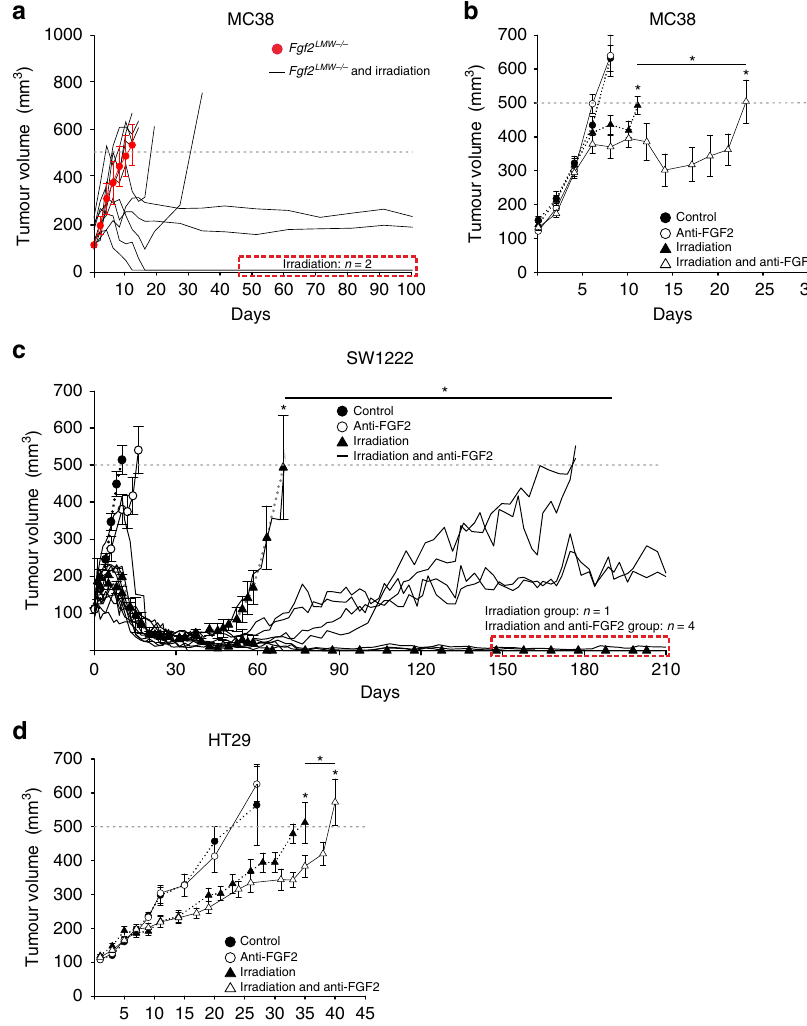
Fig. 7 Effect of irradiation and reduced FGF2 on tumour growth. Growth curves of ( a ) MC38 tumours in Fgf2 LMW − / − mice ( b ) MC38 tumours in C57Bl6 mice ( c ) SW1222 in nude mice ( d ) HT29 in nude mice following anti-FGF2 antibody, irradiation or combination therapy as indicated. N is shown at Supplementary Fig. 5E. * represents statistical signi fi cance compared with control mice ( p ≤ 0.05). Error bars indicate